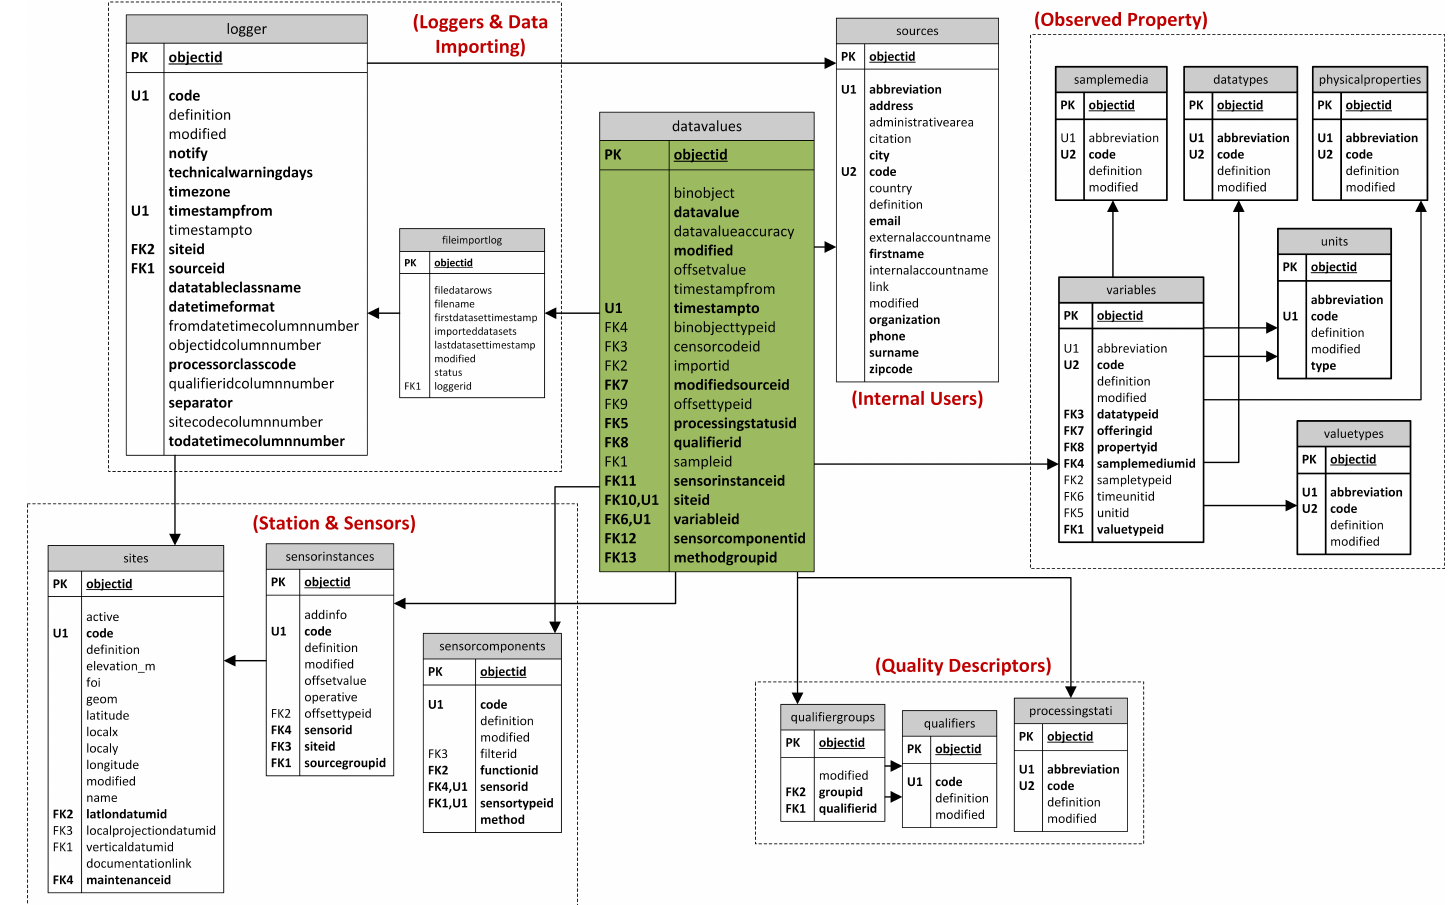
Two quality information are attached to observation values supplied by the implemented service, i.e. , quality flags ( qualifiergroups and qualifiers ) and data processing level ( processingstati ). The table source contains information about all users involved in sensors maintenance and operation, data processing, quality assessment and release. The details about data sensing and importing of observation values are specified in sites , variables , and fileimporting , and their associated